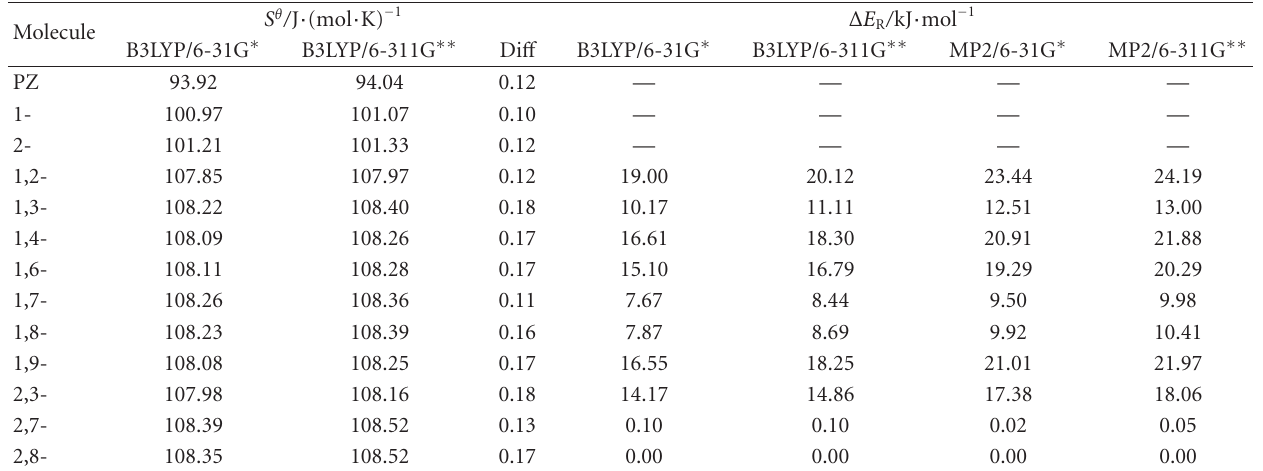
Table 2: Comparison of S θ and Δ E R calculated at di ff erent